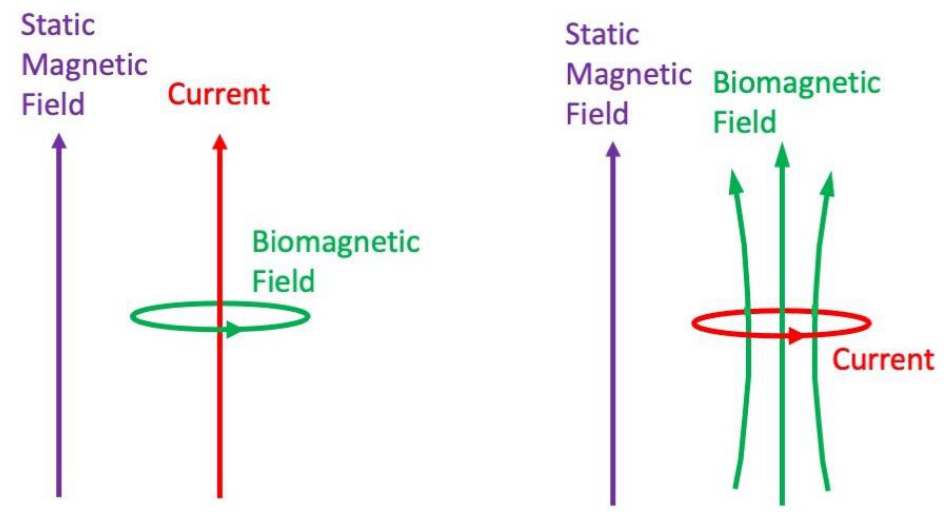
Figure 9. On the left, the current is in the same direction as the static magnetic field; the biomagnetic field has no component parallel to the static field. On the right, the current is in the plane perpendicular to the static magnetic field; the biomagnetic field has a component parallel to the static field. Only a biomagnetic field with a component parallel to the static magnetic field will change the phase of the spins.